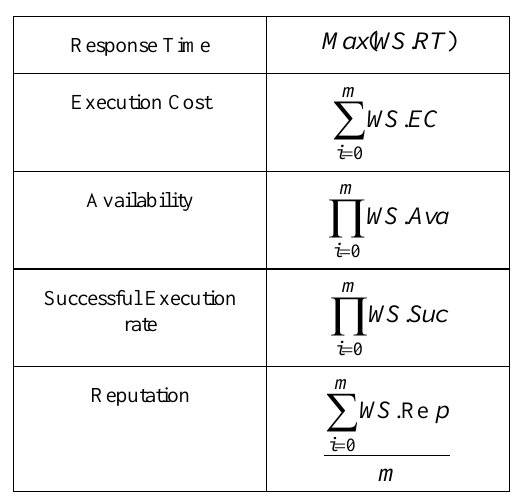
Figure. 7. AND-parallel pattern. Table 5. Aggrigative QoS value for XOR-parallel